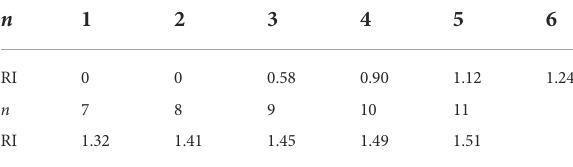
TABLE 5 Weighting result of entropy weight method.